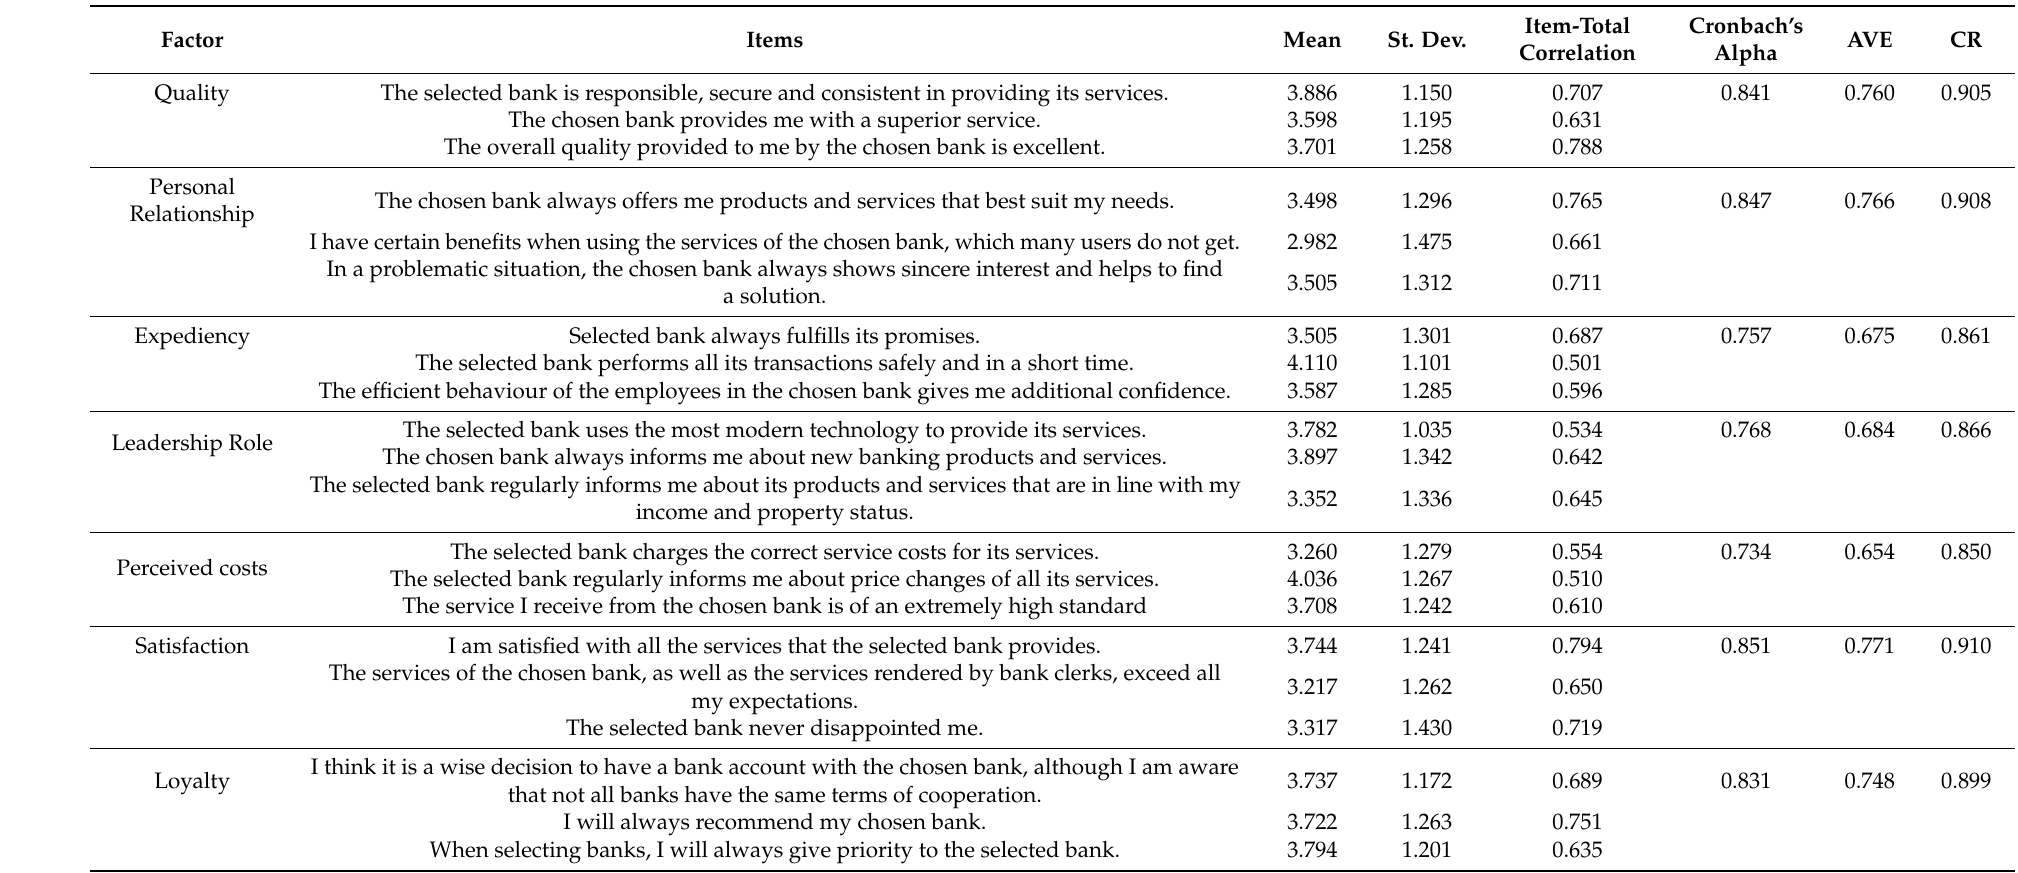
Table 2. The analysis of the proposed